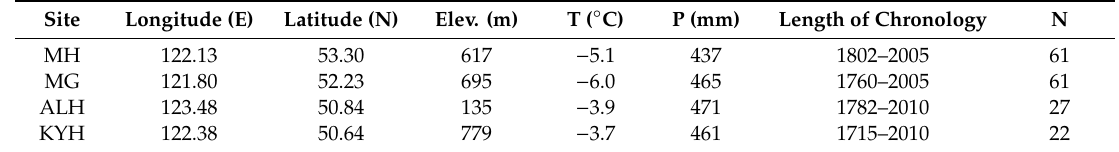
Table 1. Characteristics of four sampling